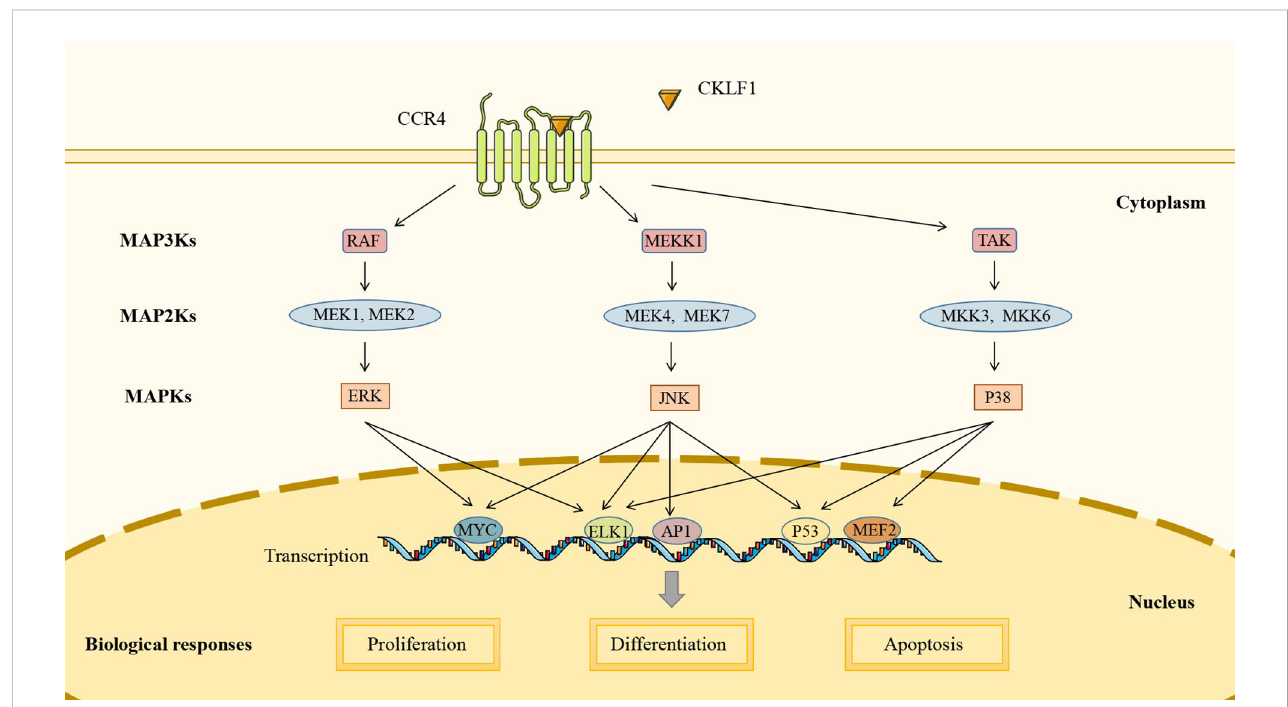
FIGURE 2 CKLF1 mediates cell proliferation, differentiation, and apoptosis by binding to CCR4 and activating the MAPK signaling pathway to induce intranuclear gene transcription.